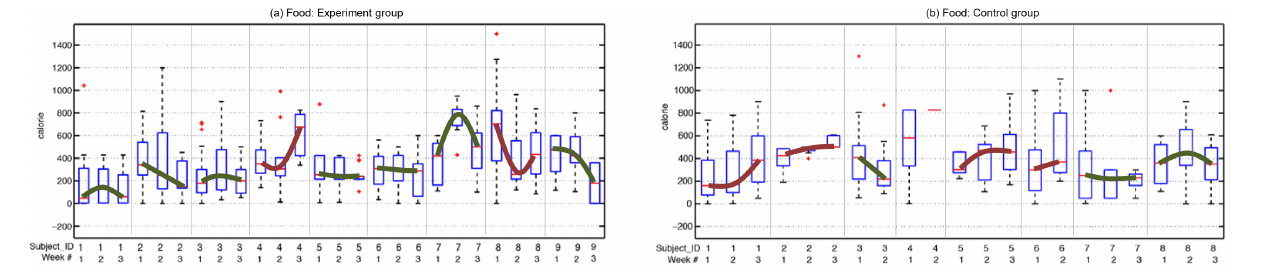
Figure 6. Box plots showing the distribution of food calories for the experimental group (a) and for the control group (b) over the 3-week study. We joined the medians of distributions and showed each trend as a thick green line (increasing trend) or red line (decreasing trend) for median food calorie